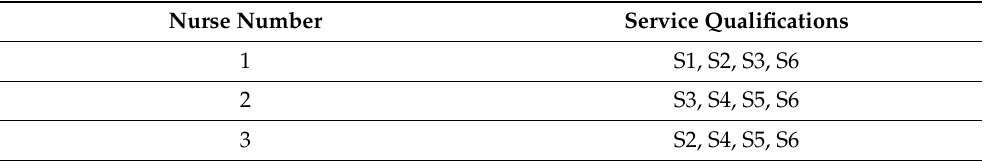
Table A3. Table A3. Properties of the nurses for the first category